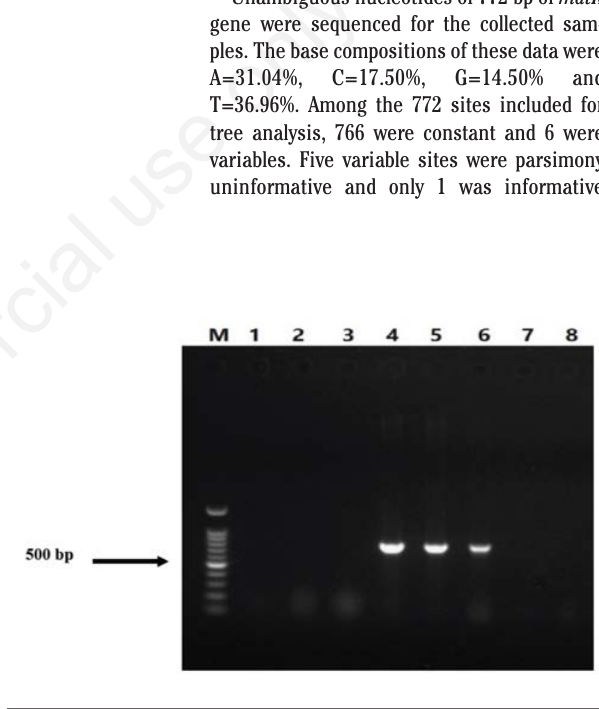
Figure 2. The amplified products of the chloroplast matK gene for eight rose samples. R. x damascena trigintipetala (lanes 1-5),